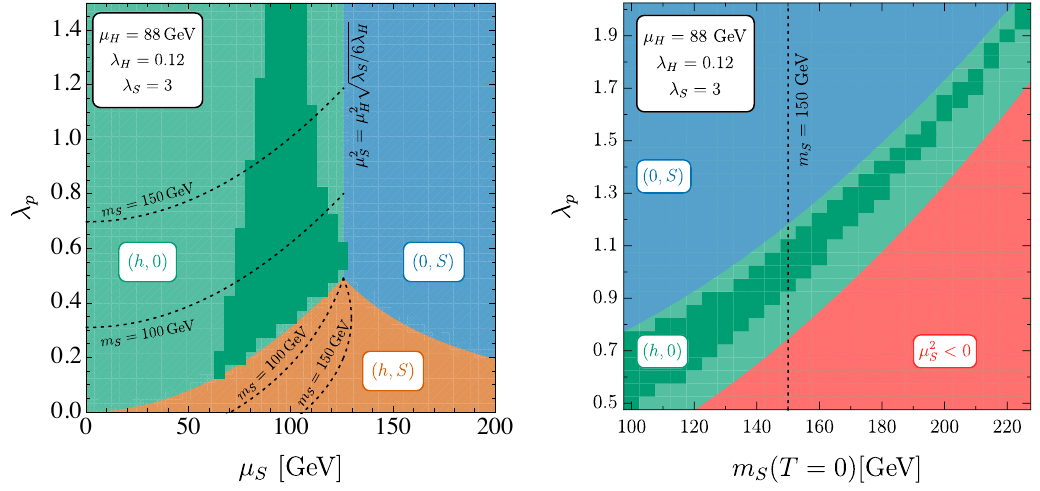
Figure 4 . Left: the phase diagram showing which (cid:12)elds obtain a vev in the global minimum of the tree-level e(cid:11)ective potential at T = 0, as a function of (cid:22) S and (cid:21) p . Also shown is m S ( T = 0) for the physical ( h; 0) and ( h; S ) minima. In (0 ; S ) electroweak symmetry is not broken, so it is not physical. Right: the region where a two-step phase transition occurs (green) along with regions where S never obtains a vev (red) and where electroweak symmetry is not broken at T = 0 (blue) as a function of m S ( T = 0) and (cid:21) p . Superimposed on both in dark green is the region where cosmoTransitions gives a two-step phase transition for the one-loop e(cid:11)ective